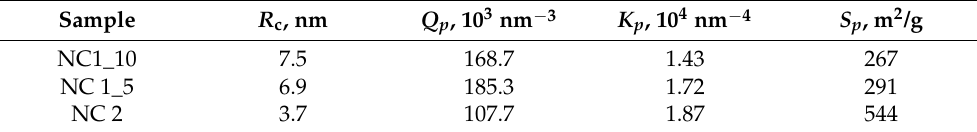
Table 4. Parameters of porous structure of synthesized nanocomposites by the SAXS